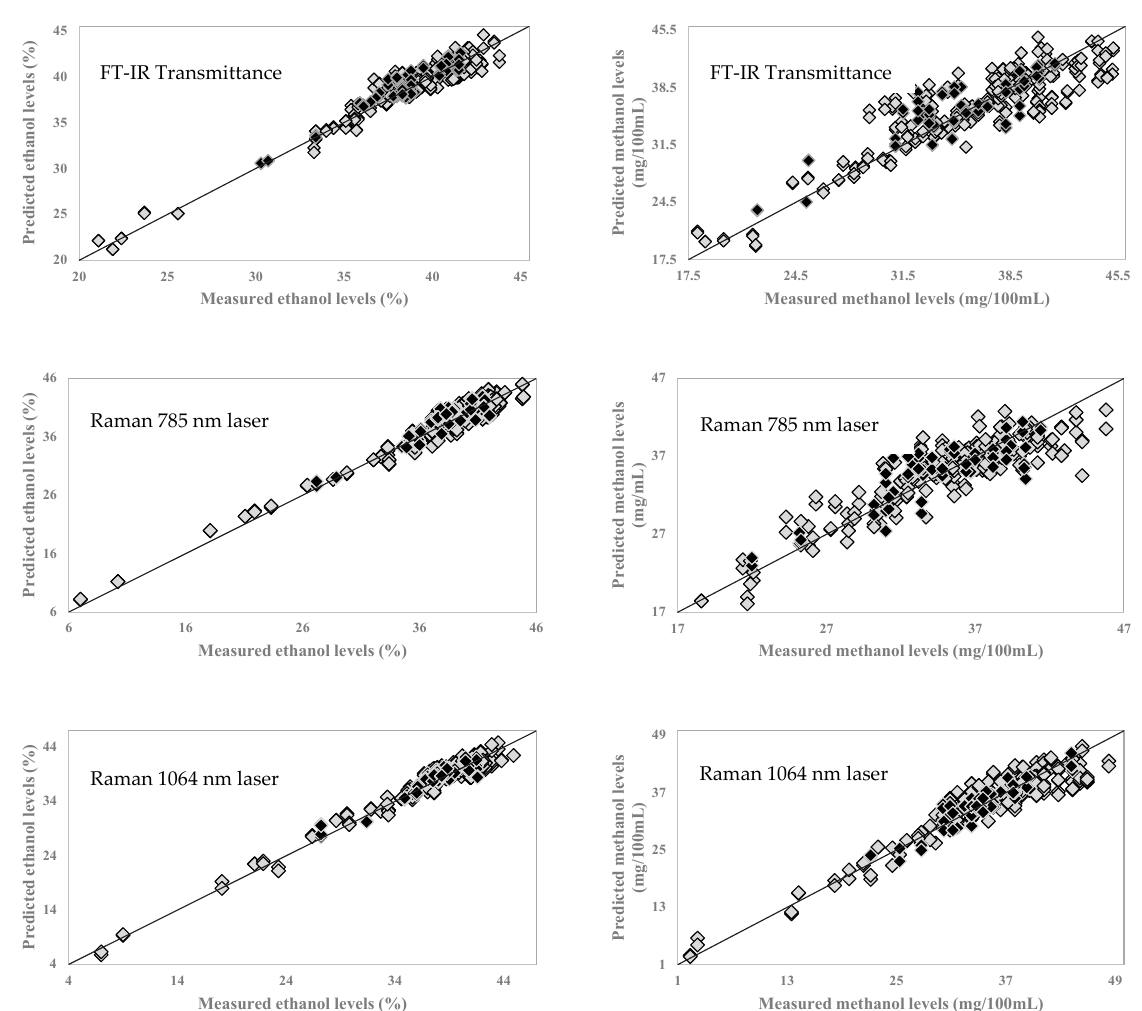
Figure 3. Partial least-square regression (PLSR) calibration and validation plots for ethanol and methanol levels in Peruvian Pisco samples using handheld Progeny Rigaku (1064 nm) and Metrohm Mira M3 (785 nm) Raman instruments and a portable FT-IR sensor. Grey diamonds represent samples in the calibration set, black diamonds represent samples in the external validation set.